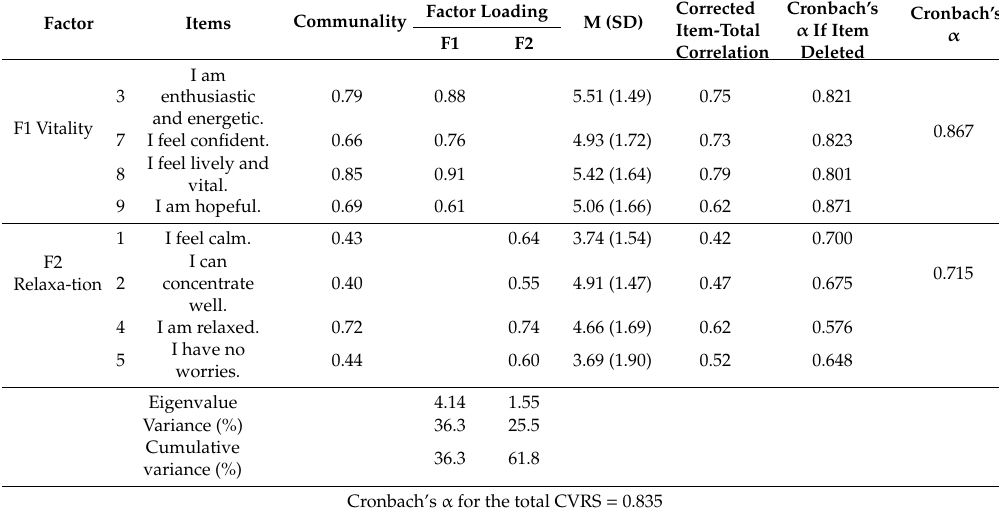
Table 2. Factor analysis and reliability of the Child Vitality-Relaxation